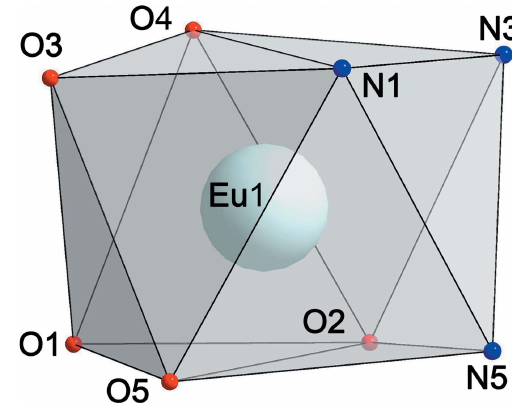
Figure 3 The geometry of the Eu 3+ coordination